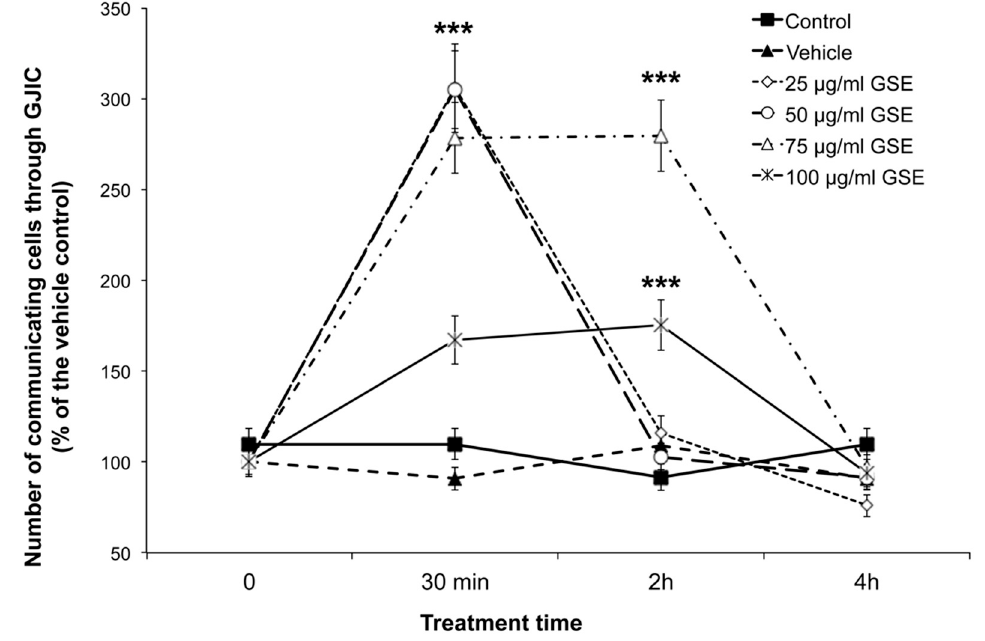
Figure 5. Dose- and time-response of GSE treatments on gap junction intercellular communication (GJIC) in MCF-7. Data are expressed as percentage of the relative controls and are expressed as the mean ± SD of three independent experiments ( n = 6). ** p ≤ 0.03, *** p ≤ 0.01.